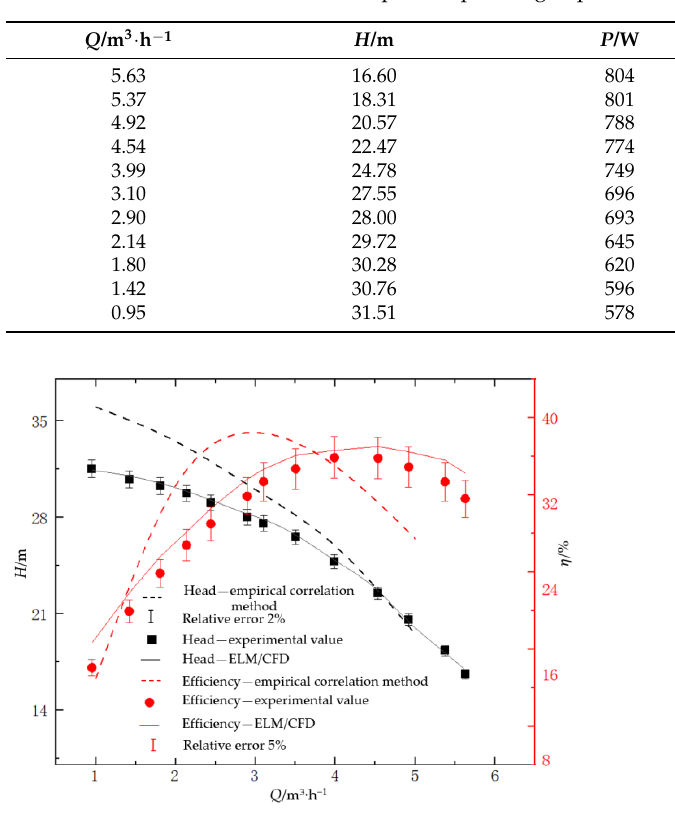
Figure 5. Comparison between numerical simulation results and experimental data.